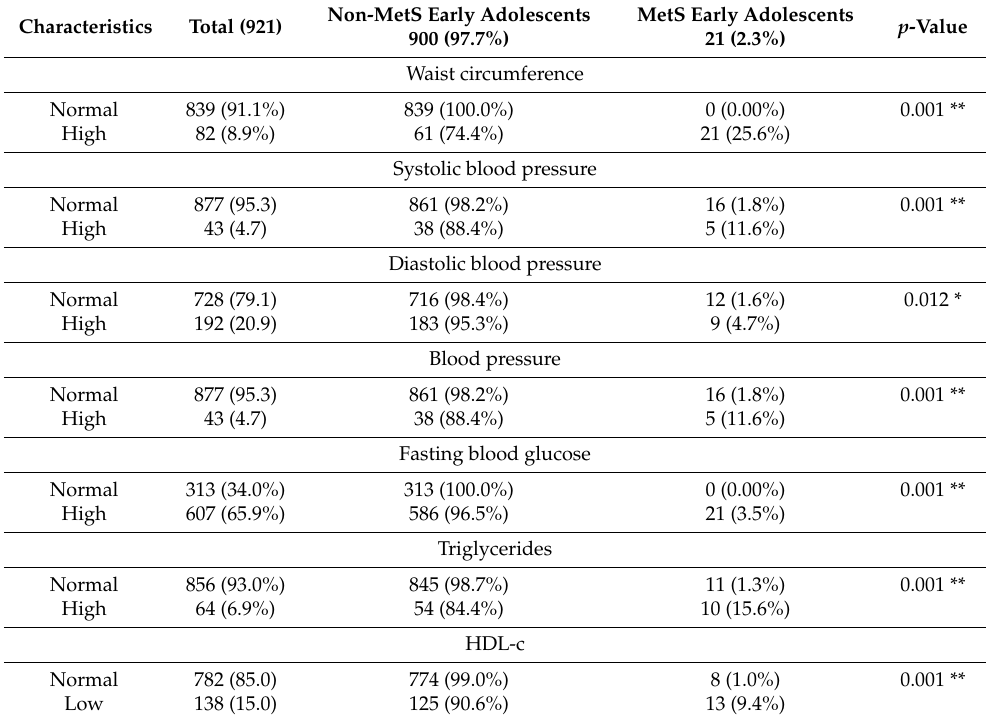
Table 3. Prevalence of metabolic syndrome components.